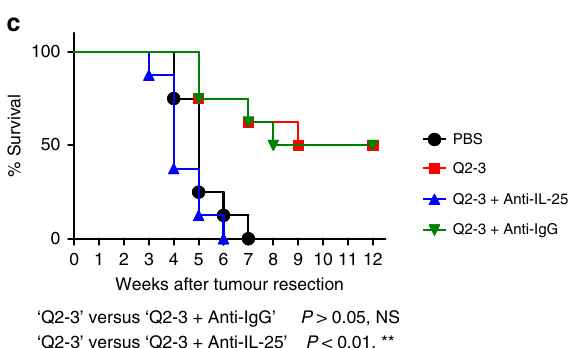
Q2-3 (100 m g kg (cid:2) 1 ) and anti-mouse IL-25 antibody (100 m g per